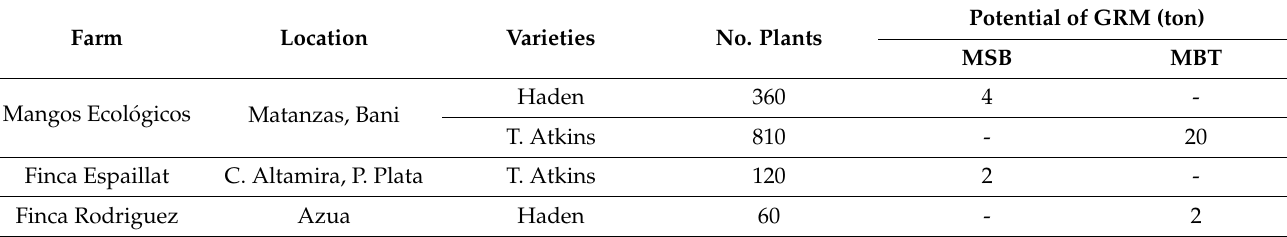
Table 1. Selection of farms for collecting mango green raw material.